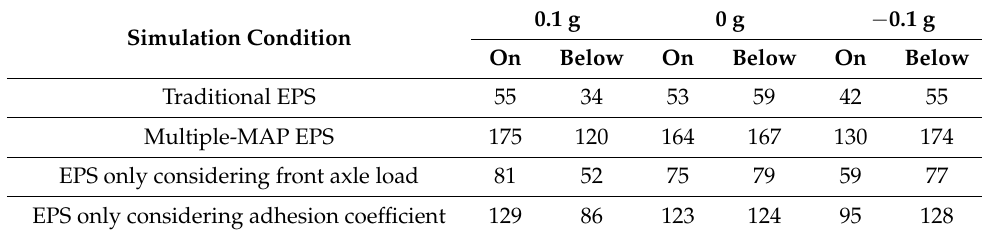
Figure 12. Results of on-center road feeling test under different EPS control strategies. Table 3. Steering wheel torque gradient at front axle load 4 t and µ = 0.2/(N·m/g).